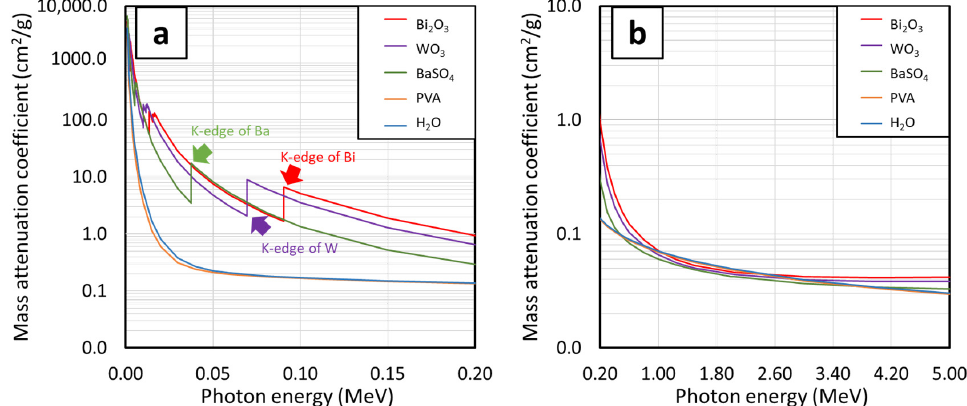
Figure 3. The µ m values of Bi 2 O 3 , WO 3 , BaSO 4 , PVA, and H 2 O showing K-edge and L-edge behaviors of Bi, W, and Ba at photon energies of ( a ) 0.001–0.2 MeV and ( b ) 0.2–5 MeV using XCOM. Figure 4, which compares the µ m values for the Bi 2 O 3 /PVA, WO 3 /PVA, and BaSO 4 /PVA hydrogels with varying filler contents of 0–40 wt.% determined at the photon energies of 0.1, 0.5, 1, and 5 MeV, reveals that strong linear correlations between the filler contents and the µ m values were observed for all investigated energies. While most of the relationships were positively correlated (Figure 4a,d), mainly due to the roles of the fillers in photon attenuation through the dominant photoelectric absorption (Figure 4a) and the pair production (Figure 4d), some of the relationships such as those of BaSO 4 /PVA (Figure 4b,c) and WO 3 /PVA (Figure 4c) were found to be negatively correlated. These negative trends were observed because, at these particular photon energies, the pristine PVA hy- drogels, which contain higher light-element (C, H, and O) contents, could better interact with the photons through the dominant Compton scattering than those of PVA hydrogels containing the fillers [26]. This phenomenon could be mathematically explained using Equation (10) as σ comp is inversely proportional to the electron densities (n e ) of the compo- sites, implying that the pristine PVA hydrogels would have higher σ comp and, conse- quently, slightly higher photon attenuation capabilities (Figure 3b).